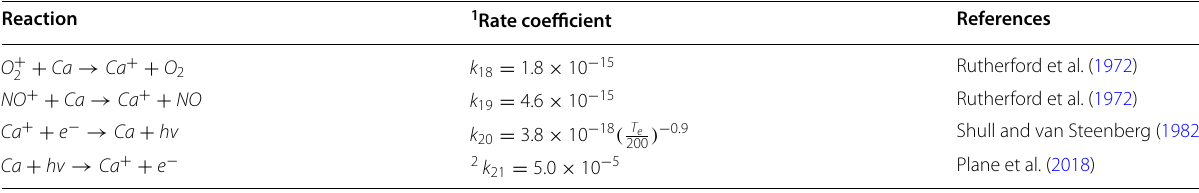
1 Units: unimolecular, s − 1 ; bimolecular, cm 3 molecule − 1 s − 1 2 k 21 is set to 0 if the solar zenith angle is greater than 90 ◦